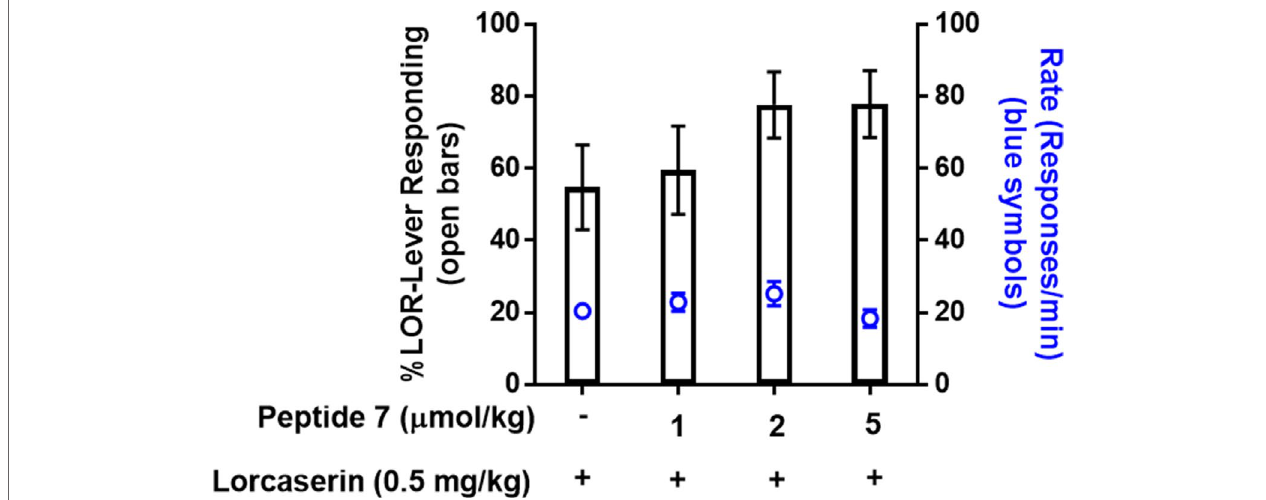
FIGURE 8 | Results of combination test of lorcaserin (0.5 mg/kg) and peptide derivative 7 (1, 2, 5 µmol/kg) in rats trained to discriminate lorcaserin (n = 14). Bars represent the mean percentage of lorcaserin (LOR)-lever responding (± SEM) observed during test sessions. Blue symbols represent the rate of response in